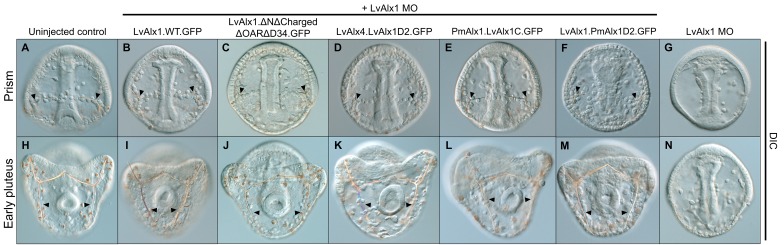
Rescued embryos show normal skeleton development at late embryonic stages.Embryos were visualized using DIC optics. (A–F) Prism stage embryos (ventral views). Arrowheads indicate spicule primordia. (H–M) Early pluteus stage embryos (posterior views). Arrowheads indicate elongated skeletal rods. (G, N) LvAlx1 morphants at the prism (G) and early plutues (N) stages showing complete lack of skeletal elements. .